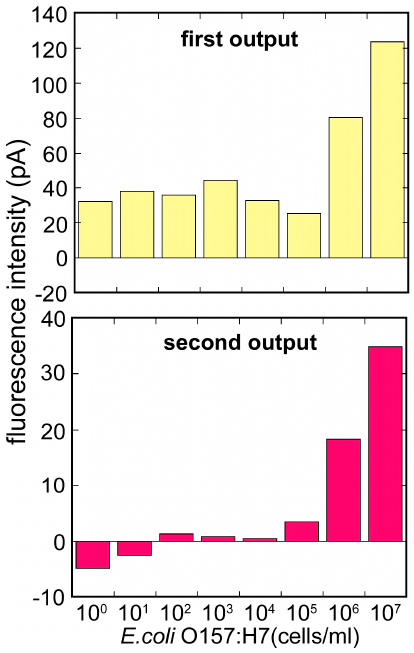
Figure 8. Comparison of the fluorescent intensity between [upper figure] the first (b/w Steps A and B: magnetic bead attach) and [lower figure] second outputs (b/w Steps B and C: magnetic bead release) to various concentrations of E. coli O157:H7 (1.0 × 10 0 –1 × 10 7 cells/mL).